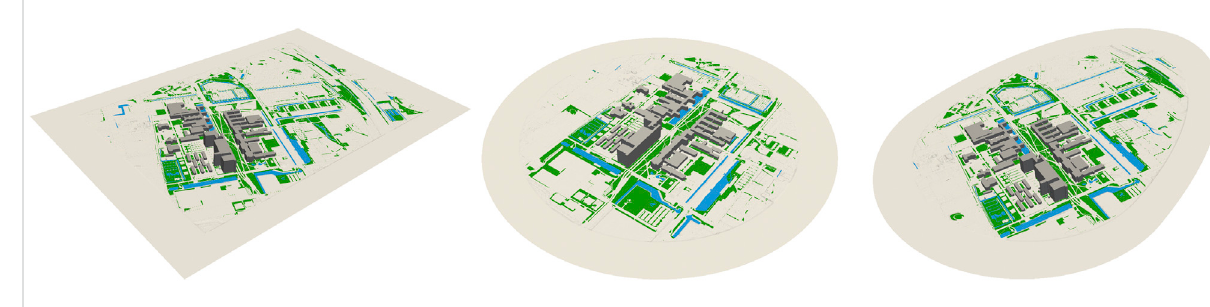
FIGURE 9 Different types of domain calculated with BPG ’ s: rectangular (left), round (middle), and oval (right).